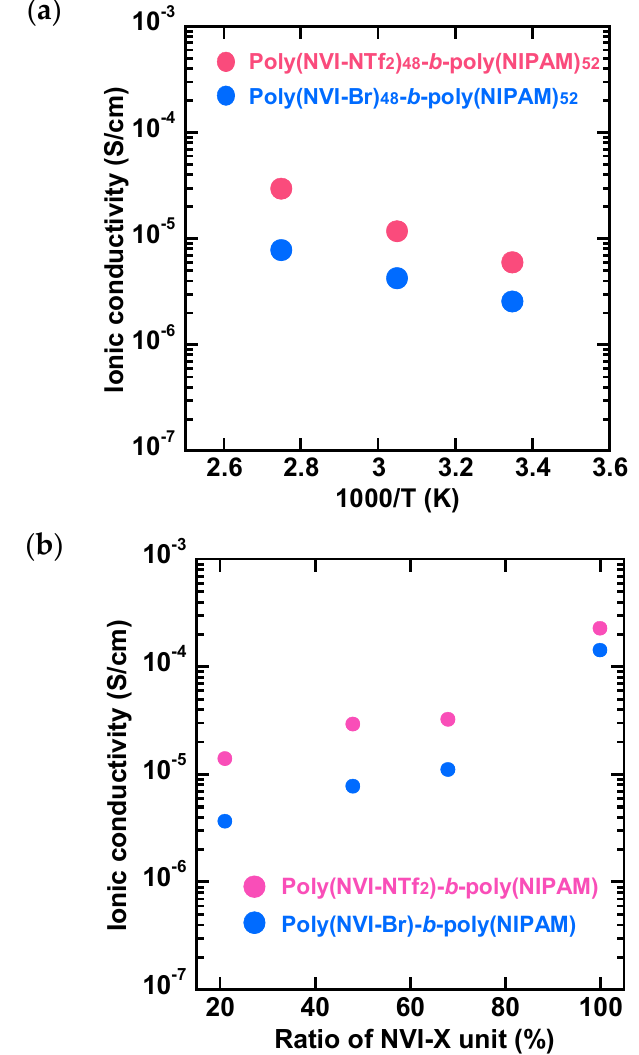
Figure 2. ( a ) Temperature-dependent ionic conductivity of poly(NVI-Br) 48 - b -poly(NIPAM) 52 and poly(NVI-NTf 2 ) 48 - b -poly(NIPAM) 52 , and ( b ) composition-dependent ionic conductivity of poly(NVI-NTf 2 )- b -poly(NIPAM)s and poly(NVI-Br)- b -poly(NIPAM)s at 90 °C. Acetone solutions of poly(NVI-NTf 2 )- b -poly(NIPAM)s were cast onto a platinum electrode and dried at 40 °C for 2 h.